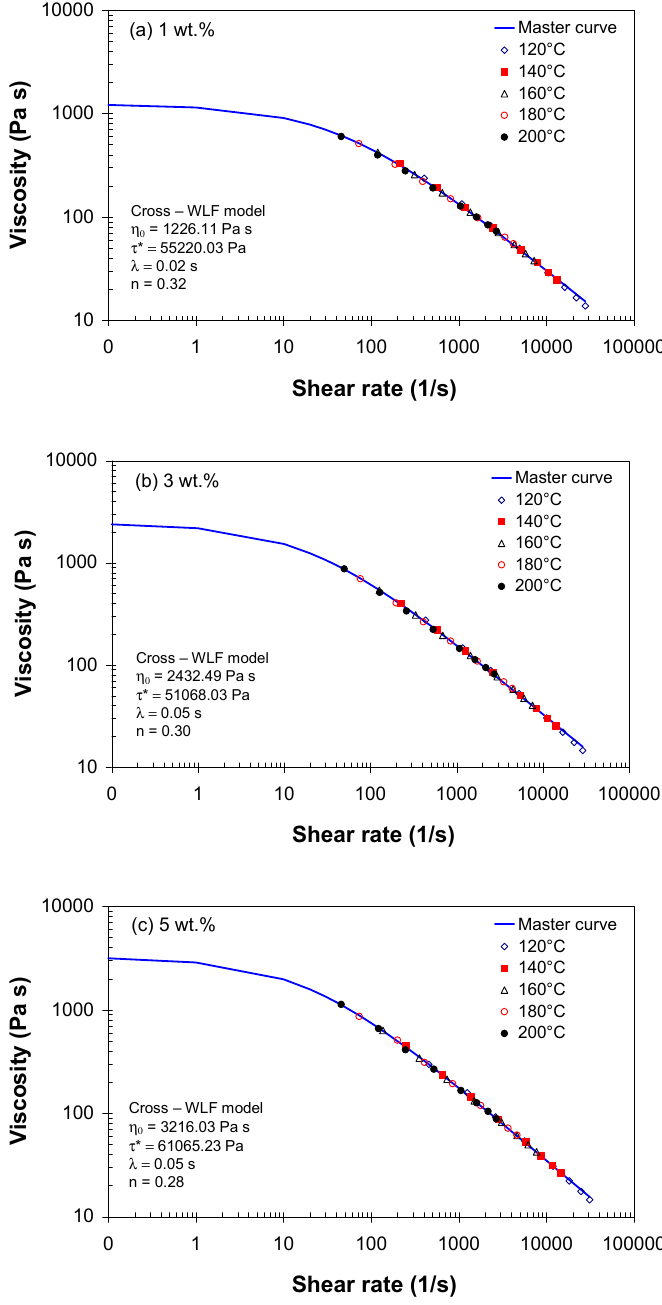
Figure 6. Master curve for EVA / MWCNT composite with ( a ) 1 wt.%, ( b ) 3 wt.% and ( c ) 5 wt.% at a reference temperature of 160 °C.